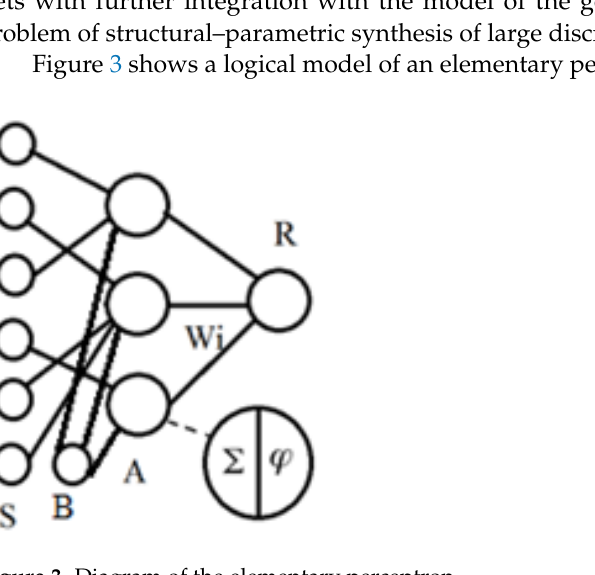
Figure 3. Diagram of the elementary perceptron.